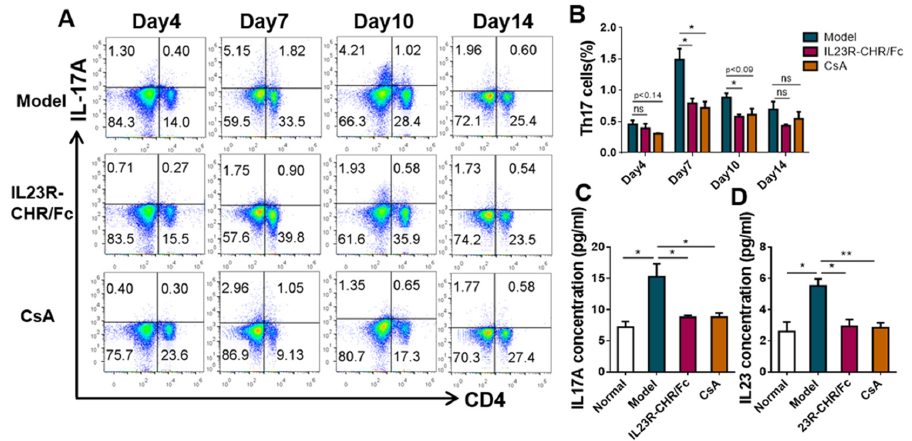
Figure 4. rhIL-23R-CHR/Fc inhibited Th17 cell-mediated inflammatory response. ( A ) Representative flow-cytometric analysis of Th17 cells (CD4 + IL-17A + ) in spleen from normal mice or mice ( n = 3) treated with IMQ at day 4, 7, 10, and 14. ( B ) Statistical data of Th17 cell percentage. ( C , D ) Protein levels of mIL-17A(C) and mIL-23(D) in mice serum. Data are mean ± SEM of n ≥ 3 per group. * p < 0.05, ** p < 0.01, and *** p < 0.001. ns, not significant (Student’s t -test).